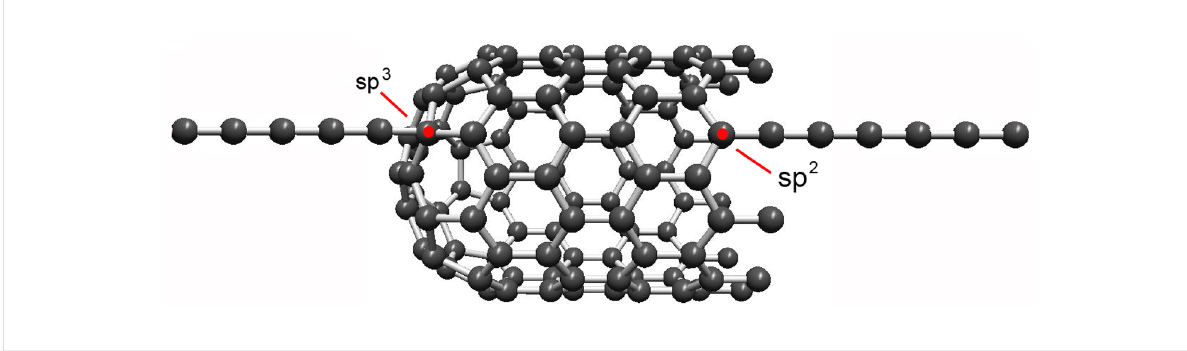
Figure 5: Different hybridization states of the end atoms of carbon chains when they are connected to a graphitic contact. The contact atoms are marked in red. As an example, chains are attached to the closed end of a carbon nanotube (left), leading to local sp 3 -hybridization, and to an open end where the contact atom is sp 2 -hybridized